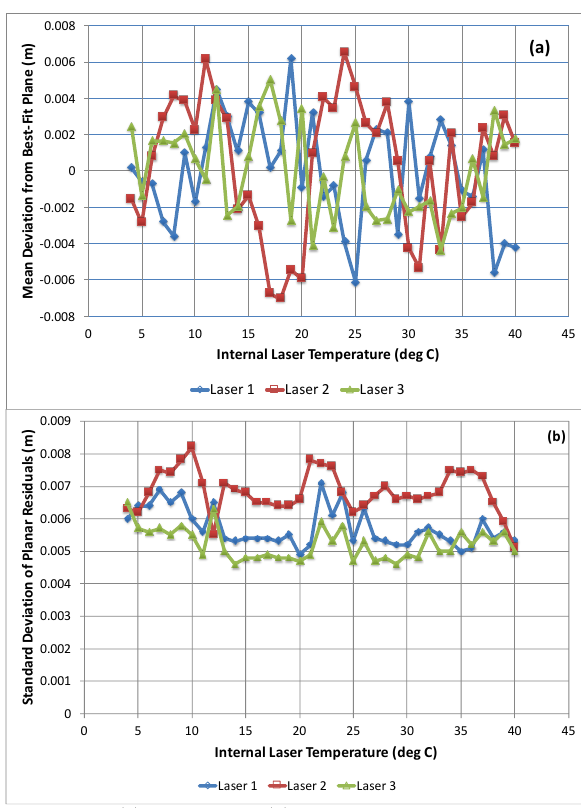
Figure 3: (a) Mean and (b) Standard Deviation of Range Residuals to Best Fit Plane over a range of internal